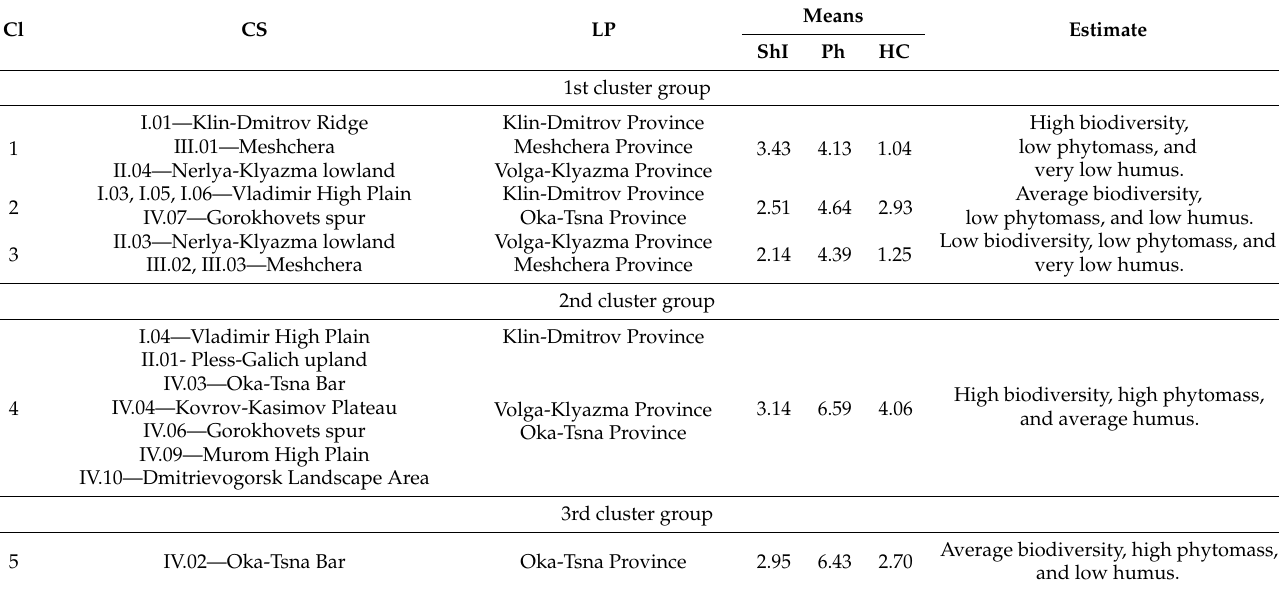
Table 4. Results of clustering of the Volga-Oka interstream area control sites.